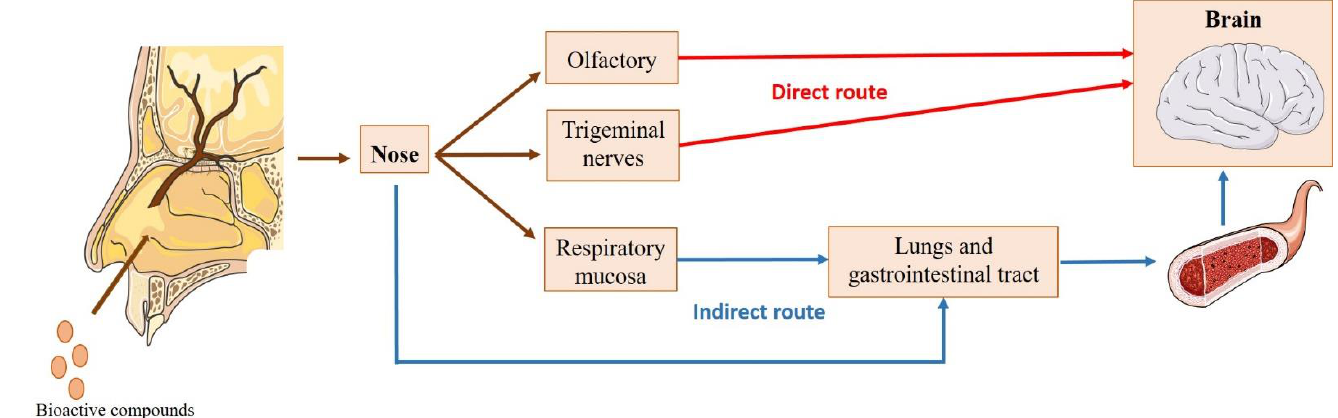
Figure 2. Possible transport routes of bioactive compounds or drugs to the brain after intranasal administration. Direct route: passage through the olfactory or trigeminal nerves, avoiding crossing the blood–brain barrier (BBB). Indirect route: absorption through the respiratory mucosa into the systemic circulation and across the BBB (adapted from Nguyen et al. [15,169]).